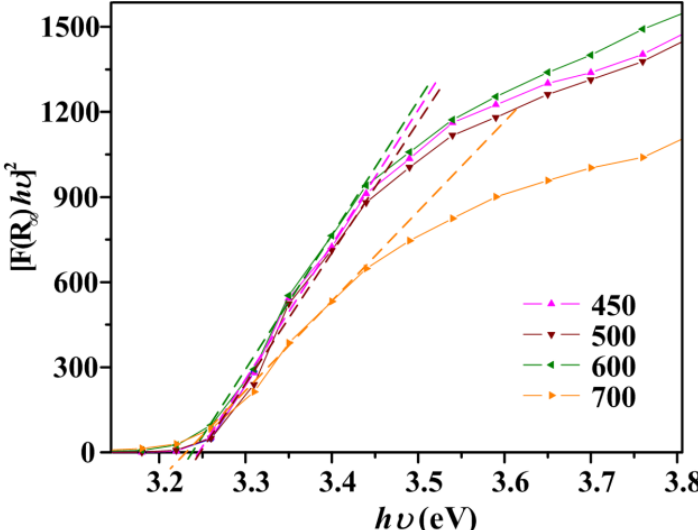
Figure 5. UV-visible diffuse reflectance spectra of ZnO nanoparticles at different calcination temperatures.